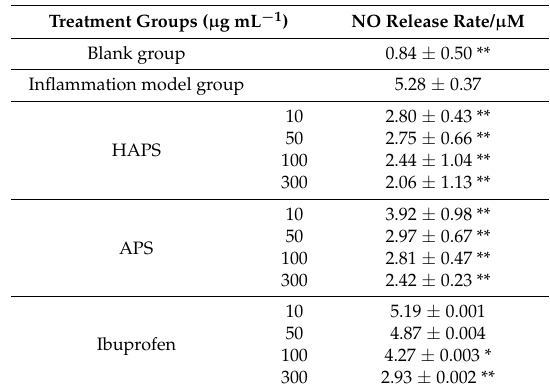
Table 4. Results of NO release after treatment of different concentration HAPS and APS.